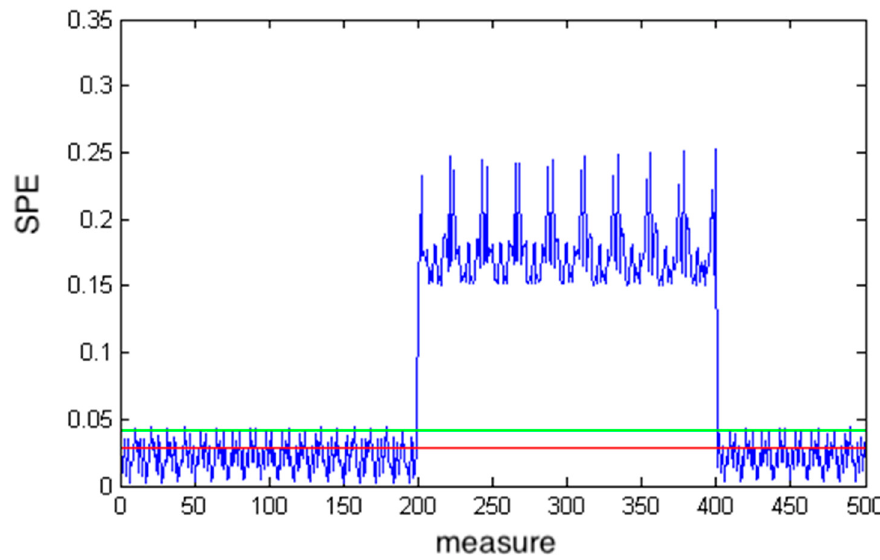
Figure 3. Fault simulation of approximation coefficient at scale 3 of X 4 .